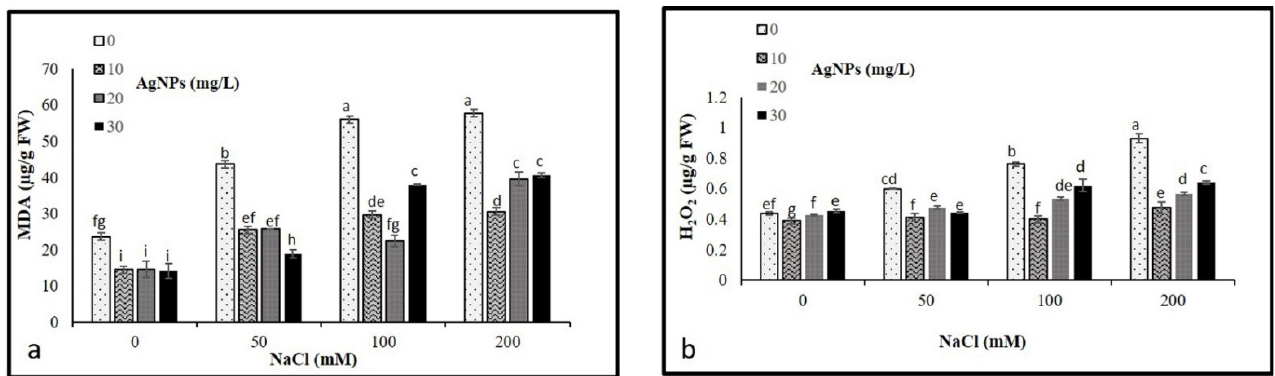
Figure 6. Contents of ( a ) MDA and ( b ) H 2 O 2 in Maerua oblongifolia leaves under salt stress and application of silver nanoparticles. Means ± SD for each treatment followed by the same letters are not significantly different according to the Duncan’s test ( p ≤ 0.05).